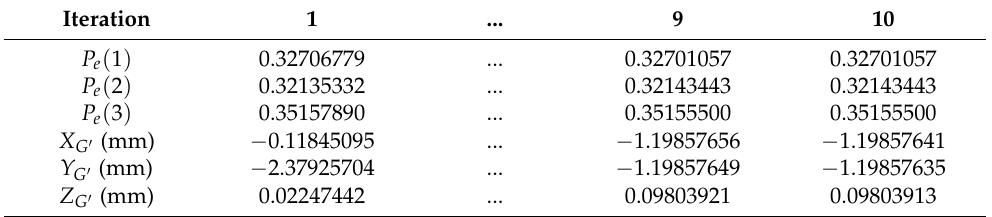
Table 18. Results of third